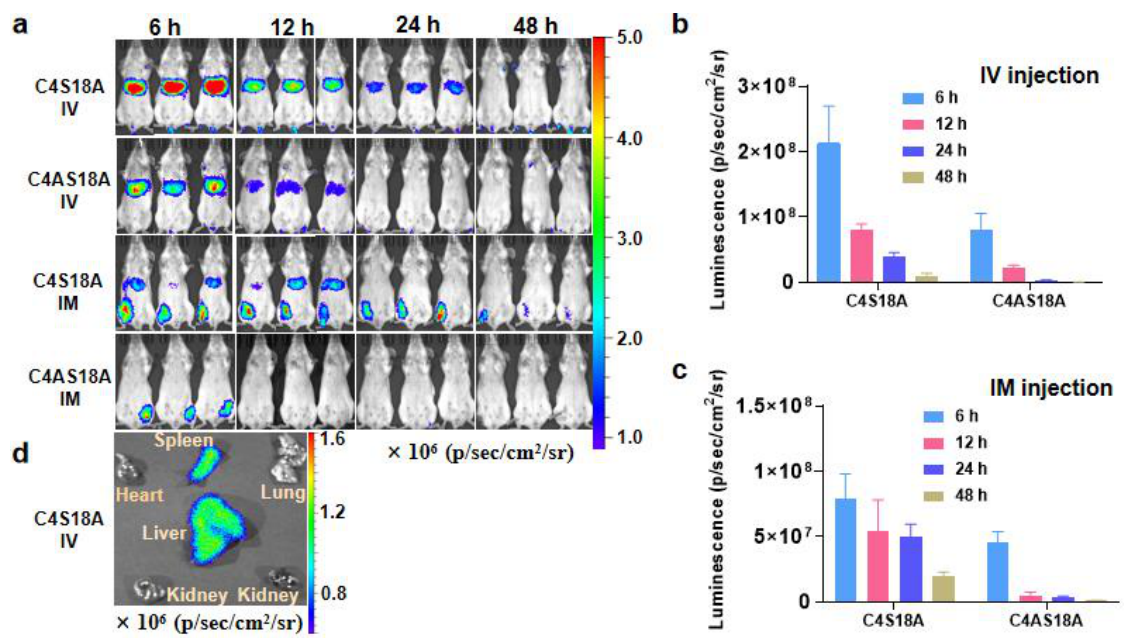
Figure 5. In vivo assays of C4A18A and C4S18A via intravenous and intramuscular administration. ( a ) Bioluminescence imaging of B/c mice (n = 3) over time after a single intravenous (IV) or intra- muscular (IM) injection of LNPs at 0.5 mg kg − 1 firefly luciferase mRNA dose. ( b , c ) Quantification of luminance intensity of Fluc−mRNA LNP over time via IV and IM administration. ( d ) Luminance intensity distribution among different organs 6 h after IV injection. Photon flux was quantified from ROI analysis. The data are representative of at least three independent experiments, and error bars indicate the SEM.